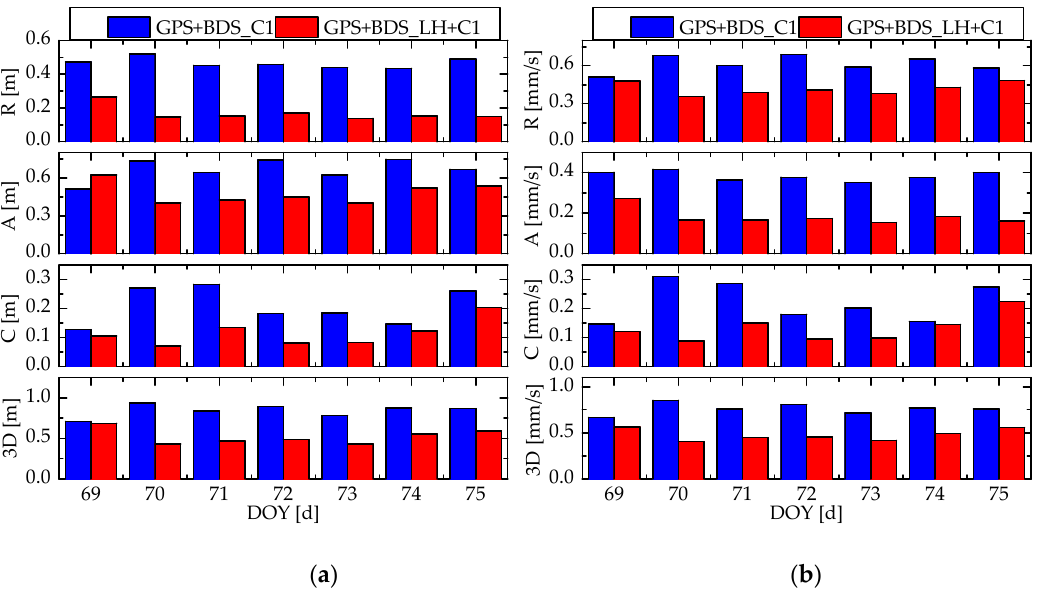
Figure 6. Comparison of daily real-time orbit accuracies of the pseudo-range-based and carrier-phase-based solutions for the FY3C satellite: ( a ) The radial (R), along-track (A), cross (C), 1-dimensional (1D) and 3-dimensional (3D) position accuracy; ( b ) The R/A/C/3D velocity accuracy.